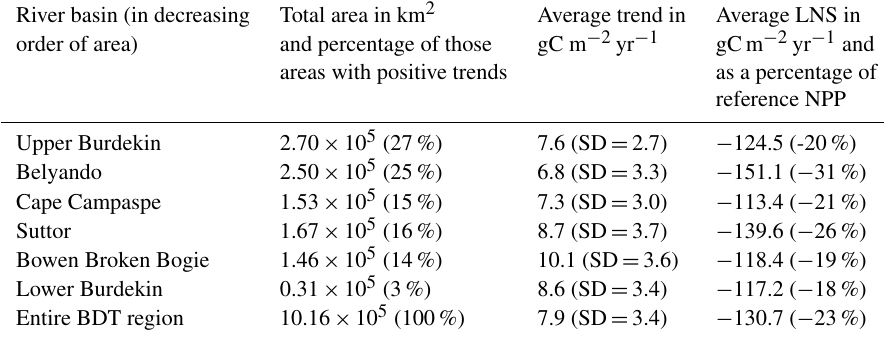
Table 7. Positive trends in area, interannual rate, and severity of LNS for river basin of the Burdekin Dry Tropics. SD – standard deviation. River basin (in